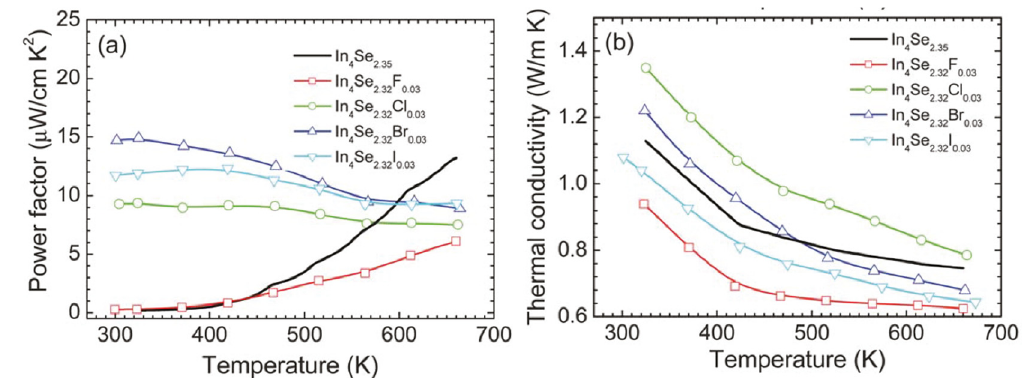
Figure 17. Temperature dependence of ( a ) power factor and ( b ) thermal conductivity of the crystals of In 4 Se 3 − x H 0.03 ( x = 0.68; H = F, Cl, Br, I) and In 4 Se 2.35